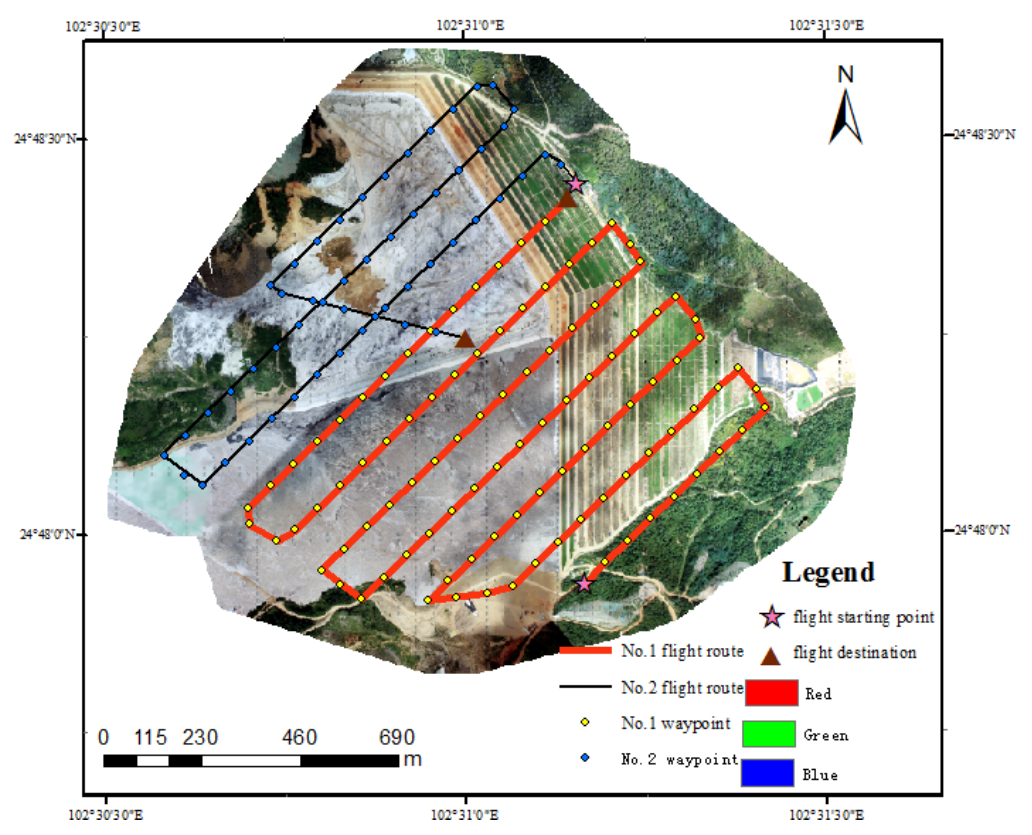
Figure 2. The specific route planning of the aerial survey.